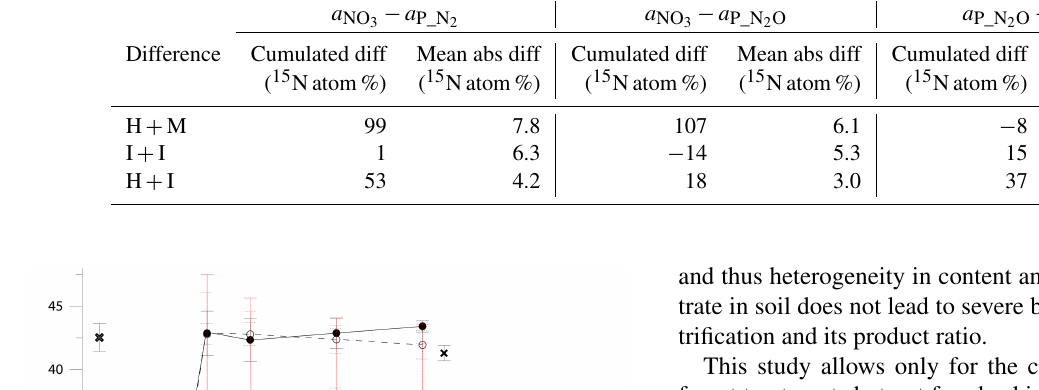
Table 3. Differences between the measured 15 N abundance in soil nitrate ( a NO ( a P_N ) and N 2 O ( a P_N ) expressed as the cumulative relative difference for all samples ( n = 24), mean absolute difference (see Sect. 2.4 2 2 O for calculation procedure). In the above equations a 1 and a 2 represent the 15 N enrichment of two compared pools ( a NO